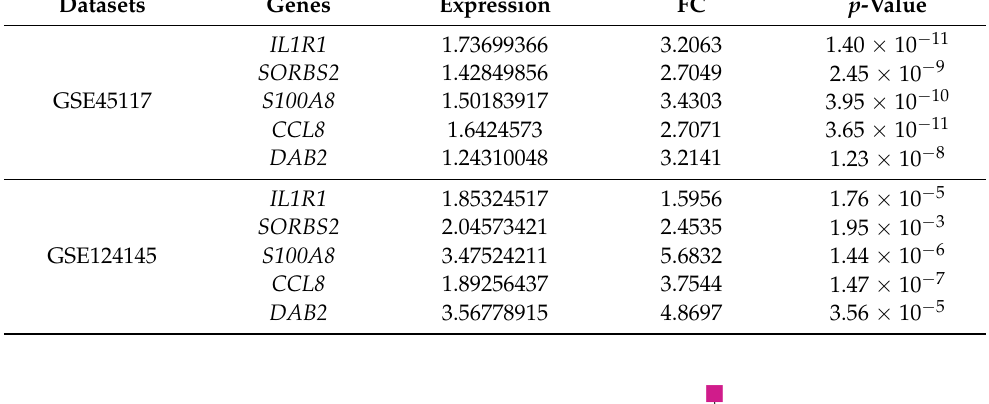
Table 6. Base-2 logarithmic scale of differential expression of most significant hub genes in two different GBM datasets.